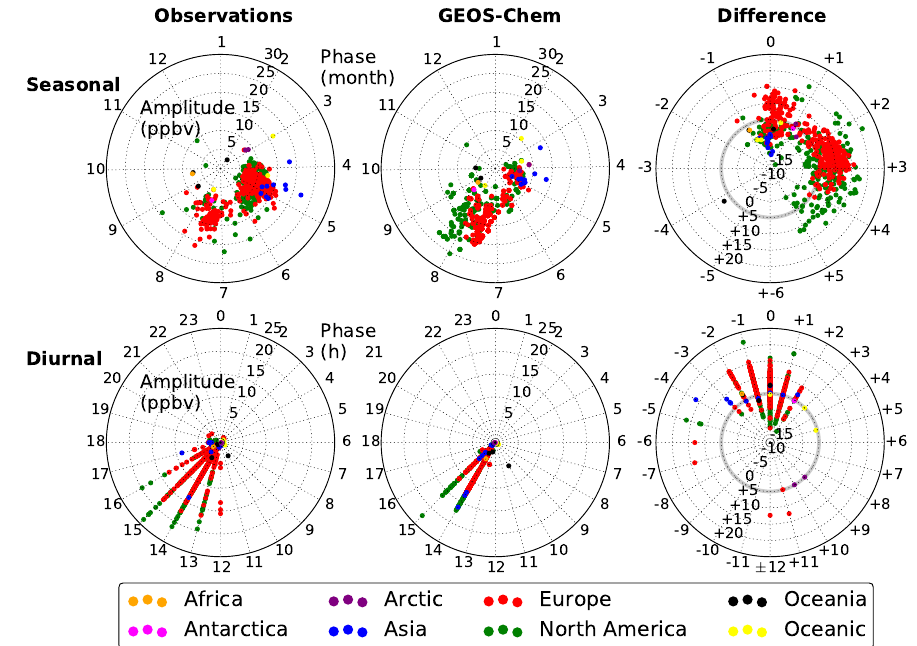
Figure 10. Polar plot of the diurnal and seasonal amplitudes and phases for observations and the GEOS-Chem model, and the differences between them. Circle colour indicates the location of the